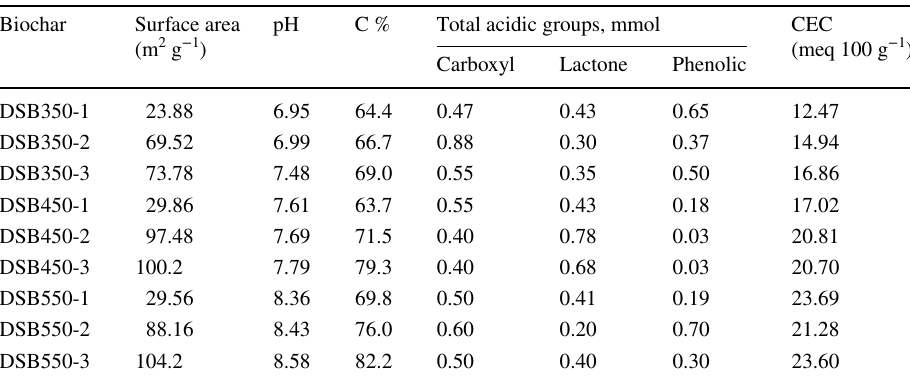
Table 2 Characteristics of biochar prepared at different pyrolysis conditions